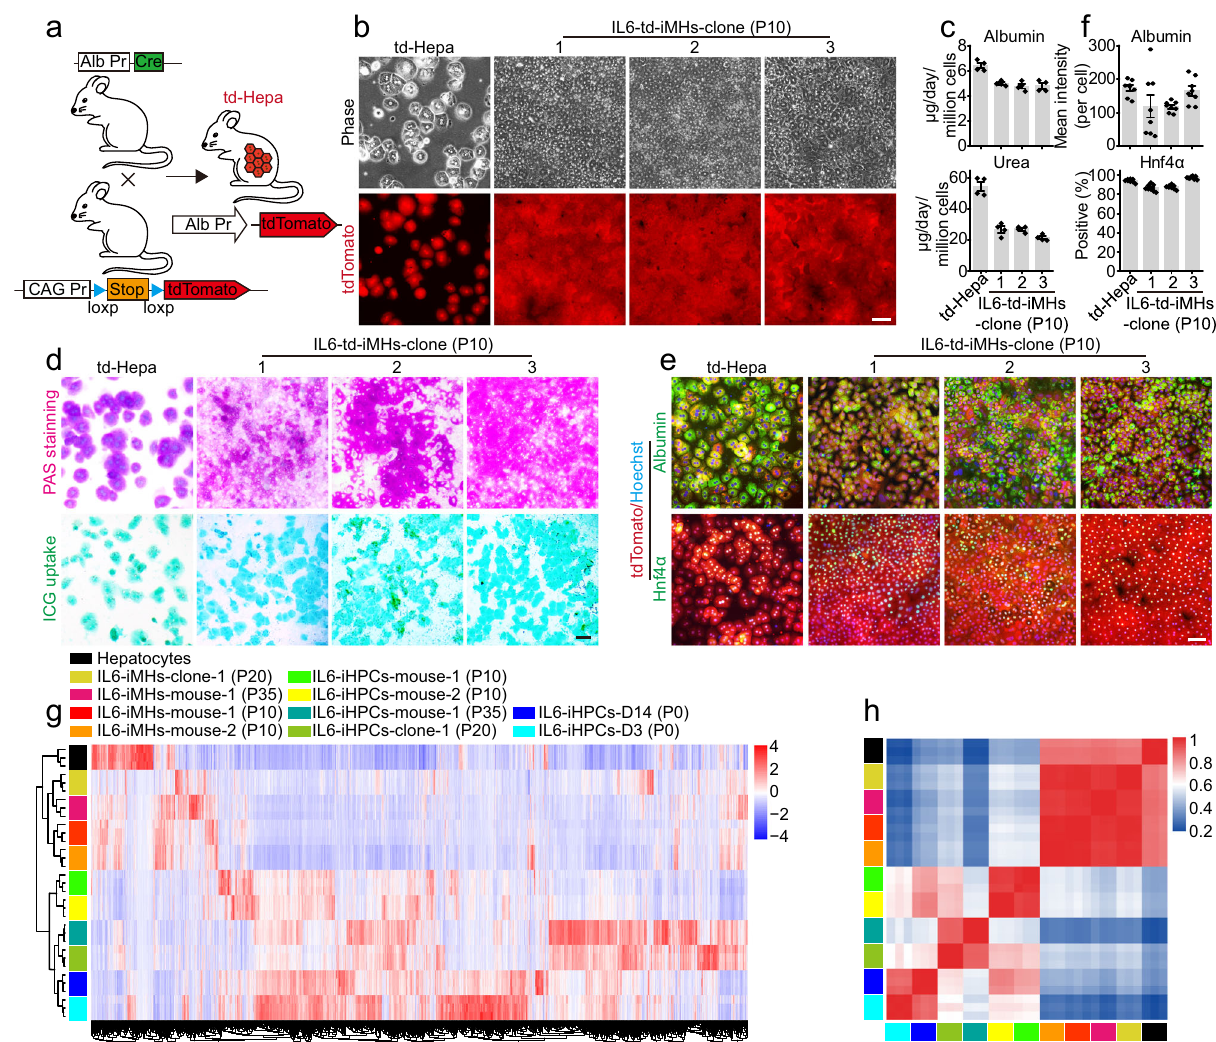
Fig.3|GenerationofiHPCclonesfromsinglecellswithIL6.a Schematicdiagram of the genetic fate mapping method used to produce mice with hepatocytes expressing tdTomato (td-Hepa). b Representative morphologies and tdTomato (red)imagesoftd-HepaandthreeIL6-td-iMHclones(P10)derivedfromsinglecells. c ThealbuminandureasecretioncapacitiesofIL6-td-iMHclones(P10)andprimary td-Hepa. Data are Means±SEM ( n =4 independent experiments). Representative PAS staining, ICG uptake ( d ) and immuno fl uorescence staining of hepatic markers Albumin (green) and Hnf4 α (green) ( e ) in primary td-Hepa and IL6-td-iMH clones (P10). Nuclei were stained with Hoechst 33342 (blue). f Statistical data of the immuno fl uorescencestainingdatain e .DataareMeans±SEM(eightrandom fi elds for each group, three independently generated IL6-td-iMH clones were